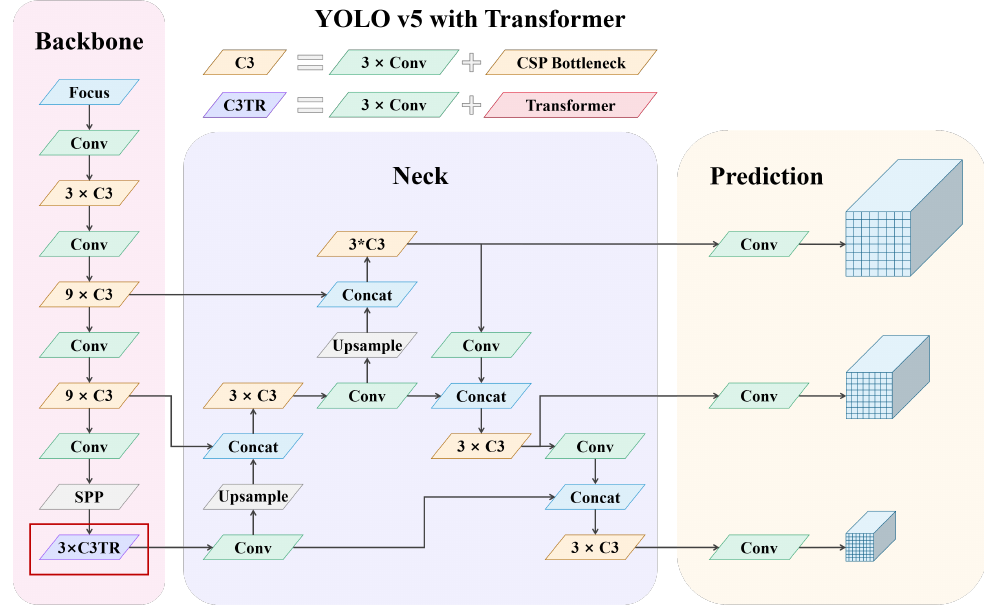
Figure 5. The network structure of YOLO